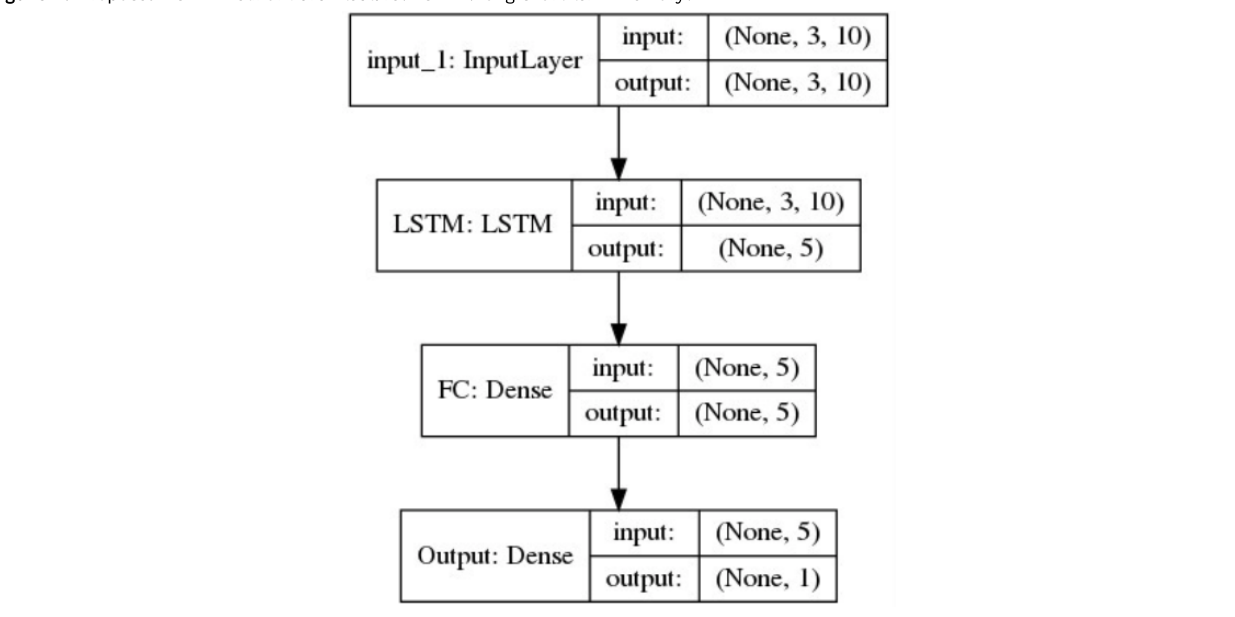
Figure 1. Proposed LSTM network architecture. LSTM: long short-term memory.